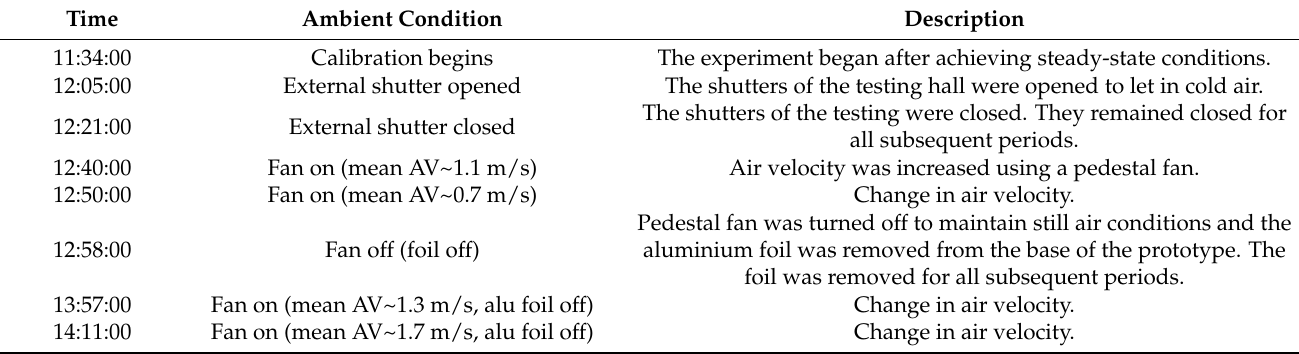
Table 2. Ambient conditions during the comparison